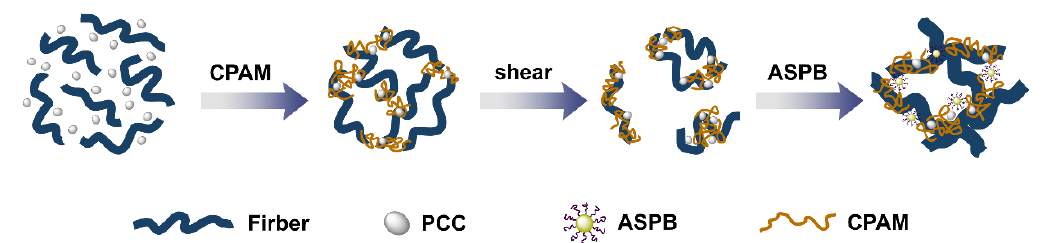
Figure 10. Flocculation mechanism of the CPAM/ASPB dual-component system.